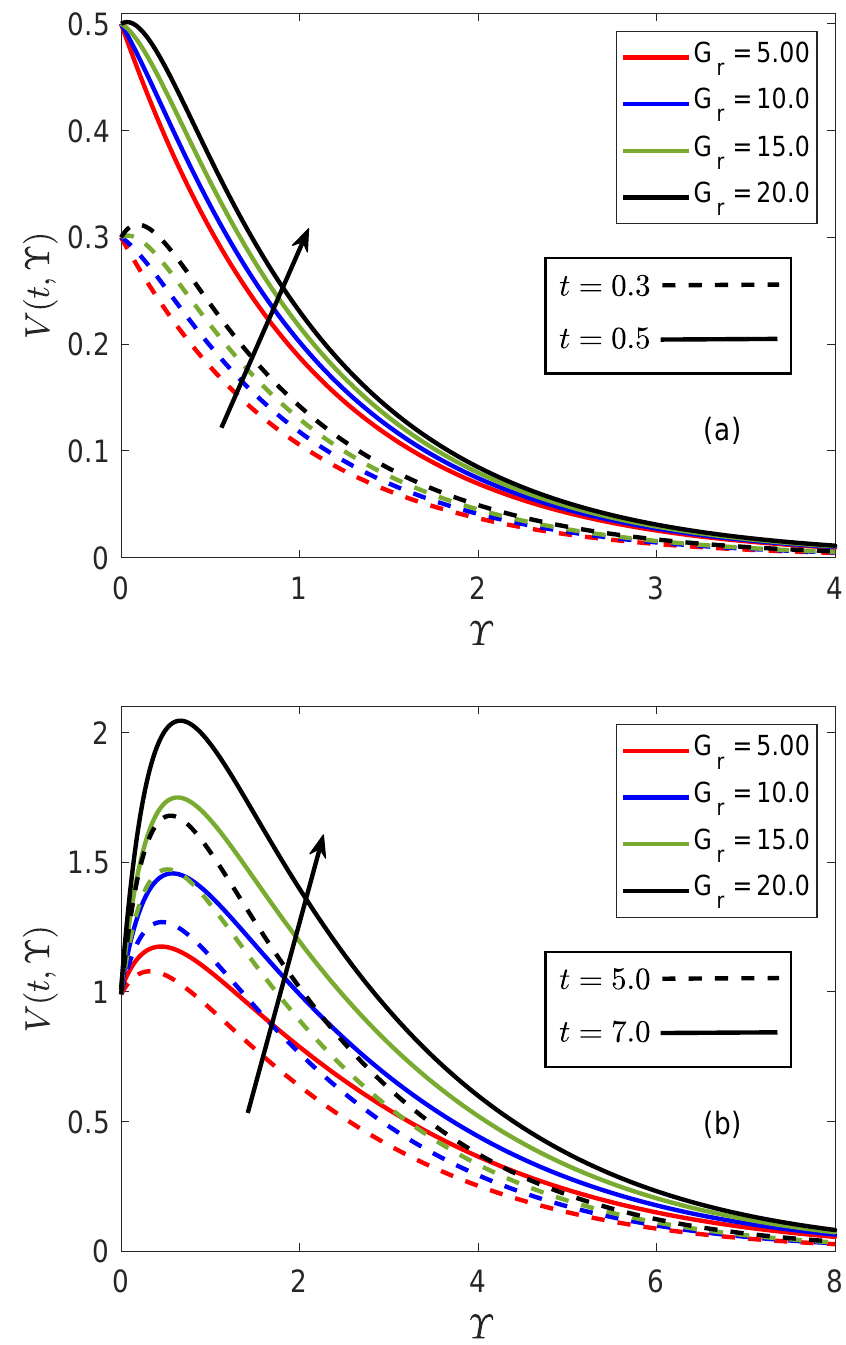
Figure 12. ( a ) Flow patterns corresponding to variations of G r for smaller time inputs. ( b ) Flow patterns corresponding to variations of G r for larger time